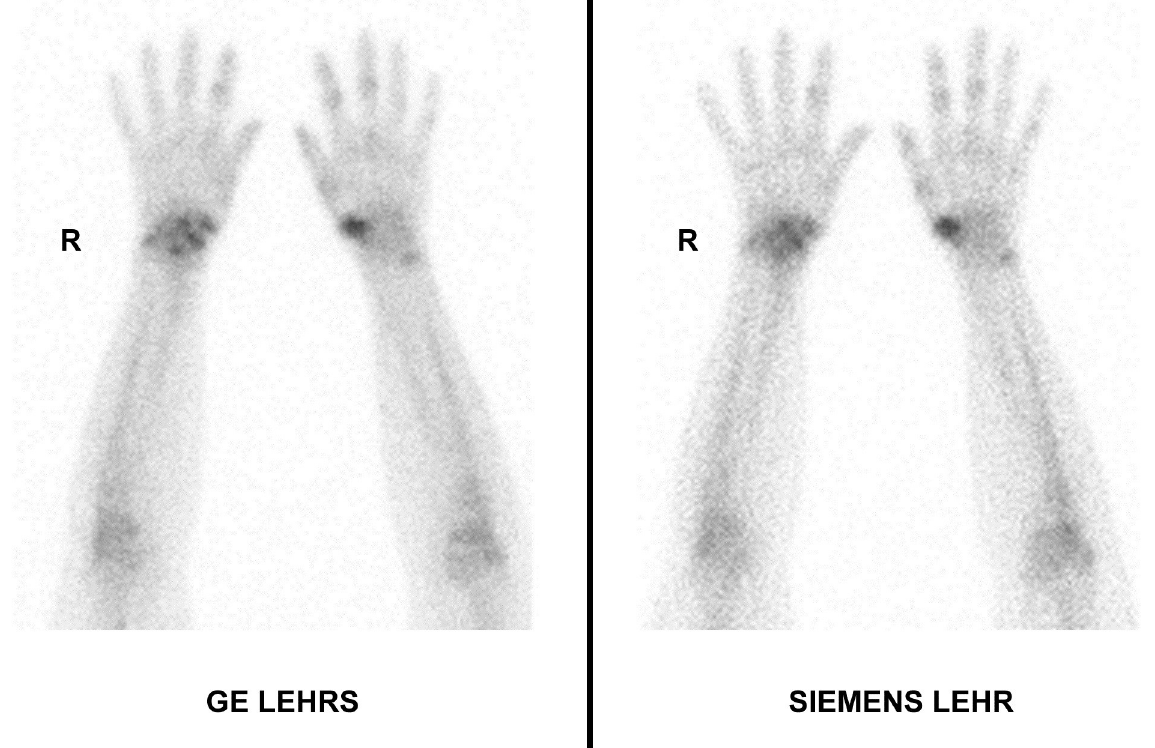
Fig 7. Hands planar acquisition in contact with collimator. More details are observed in the right carp on GE Swiftscan image.